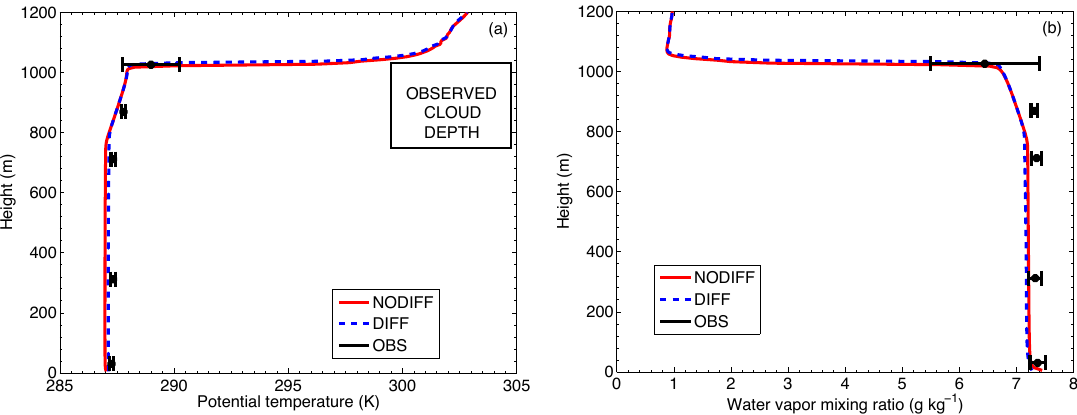
Fig. 1. Comparison of thermodynamic profiles between CIRPAS in-situ observations (data points) and LES output (lines). Observations show mean (symbol) and standard deviations (error bars) over each of the five flight legs. LES output are domain-averaged and temporally averaged over the sixth hour of simulation. Times of observations and LES output